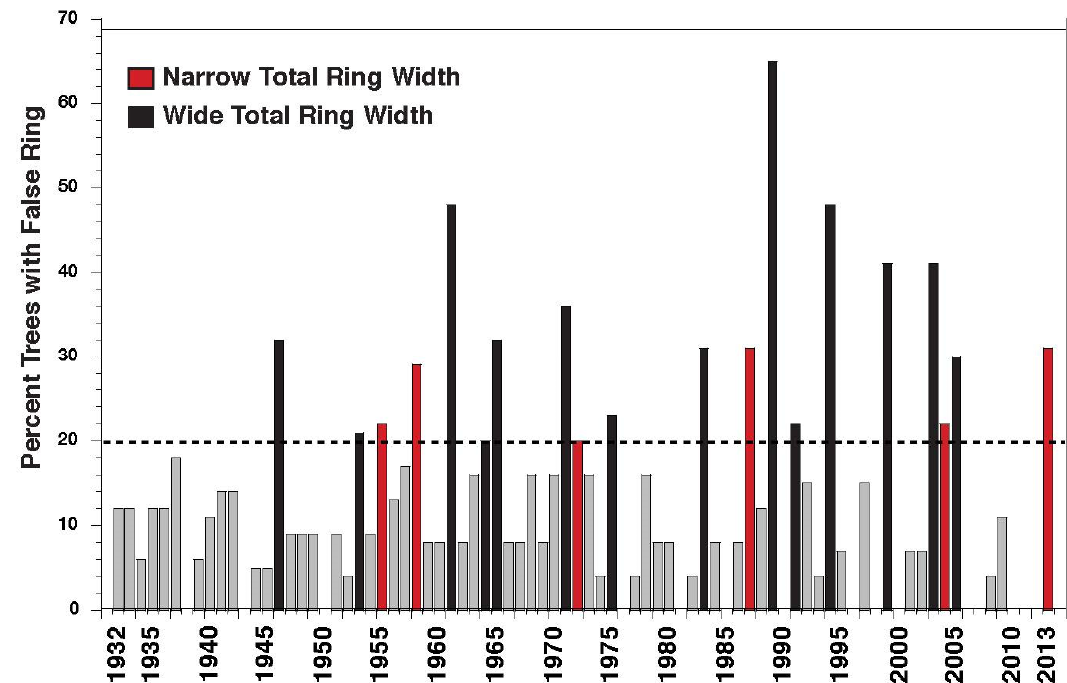
Figure 3. False ring response index chronology. Vertical bars indicate the proportion of trees exhibiting a FR in a given year. Black (wider than average rings) and red (more narrow than average rings) bars indicate years in which at least 20% of trees display a false ring (the top quartile of years). Grey bars indicate years (wide and narrow) in which less than 20% of sampled trees show a false ring.